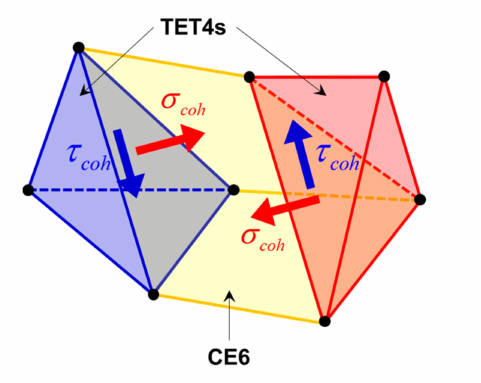
Figure 2. Types of finite elements (TET4 and CE6) in 3D finite-discrete element element method (FDEM) used in Y-HFDEM integrated development environment (IDE) code.